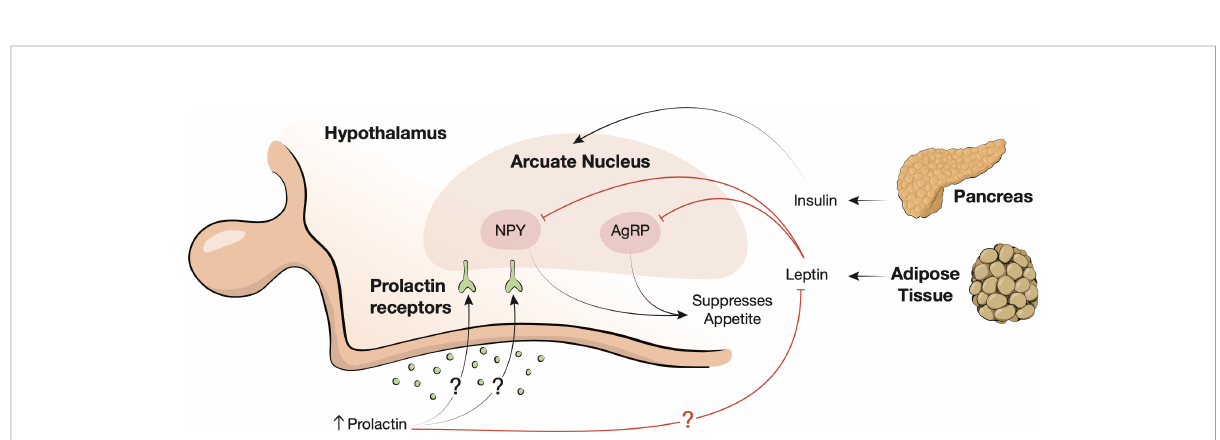
FIGURE 3 Neurohormonal appetite regulation. The arcuate nucleus of the hypothalamus integrates signals from insulin, leptin, and circulating nutrients. Leptin is secreted by adipose tissue and suppresses agouti-related protein (AgRP) and neuropeptide Y (NYP) neurons (red inhibition lines) to suppress appetite. Prolactin may also bind to the arcuate nucleus receptors leading to leptin insensitivity (red inhibition